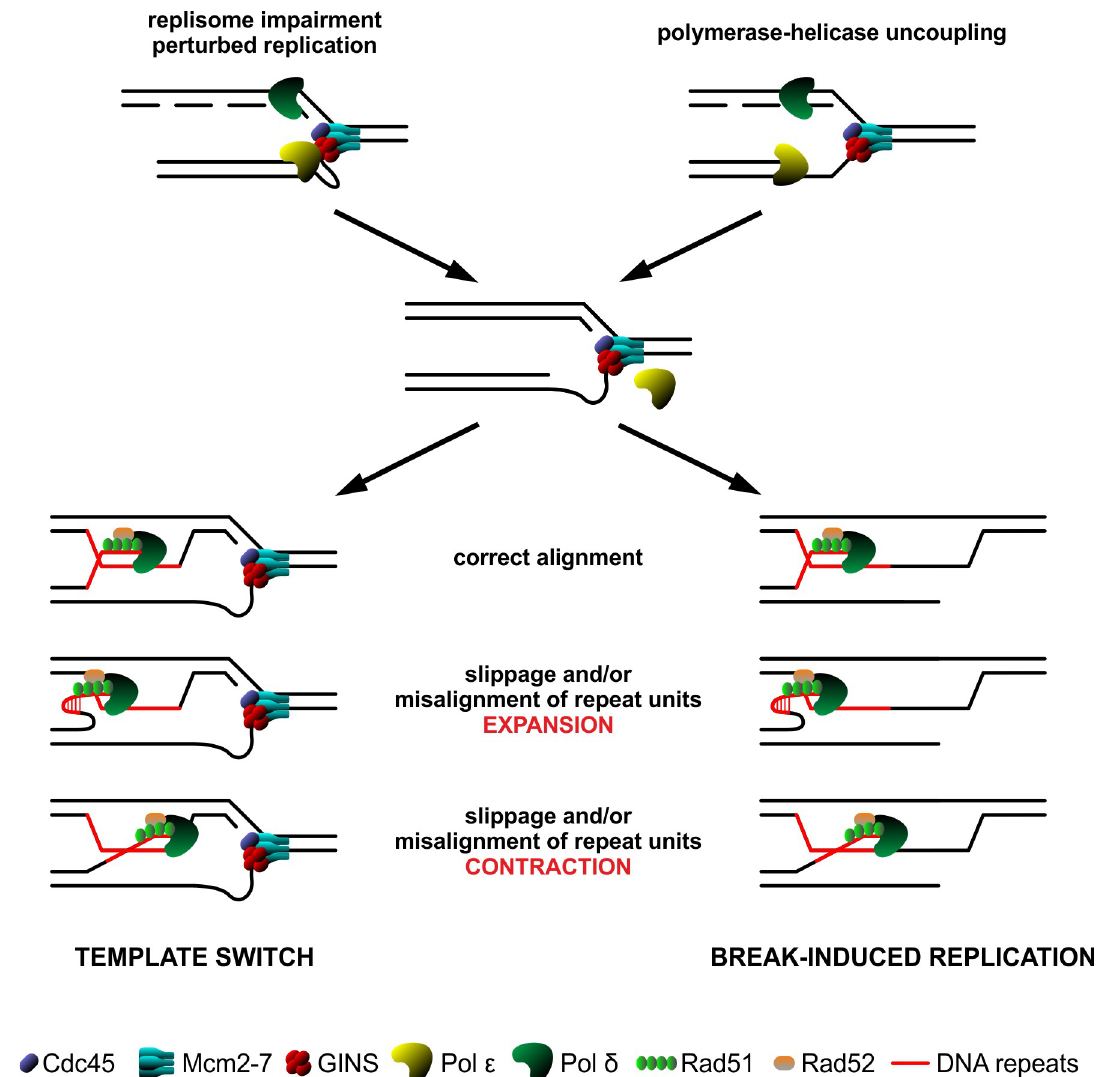
Fig 9. Schematic model for the DNA repeats instability mechanisms in the psf1-1 mutant. Defective interactions within the GINS complex of CMG-E may lead to replication perturbations and/or polymerase-helicase uncoupling and, as a consequence, formation of ssDNA gaps. To ensure the continuity of DNA duplication cells can employ various mechanisms including template switch (TS) and break-induced replication (BIR). These mechanisms require homology search which in case of a repeated DNA tract may result in misalignment leading to its expansion or contraction. Moreover, such DNA sequences may be prone to replication slippage enhancing their instability.